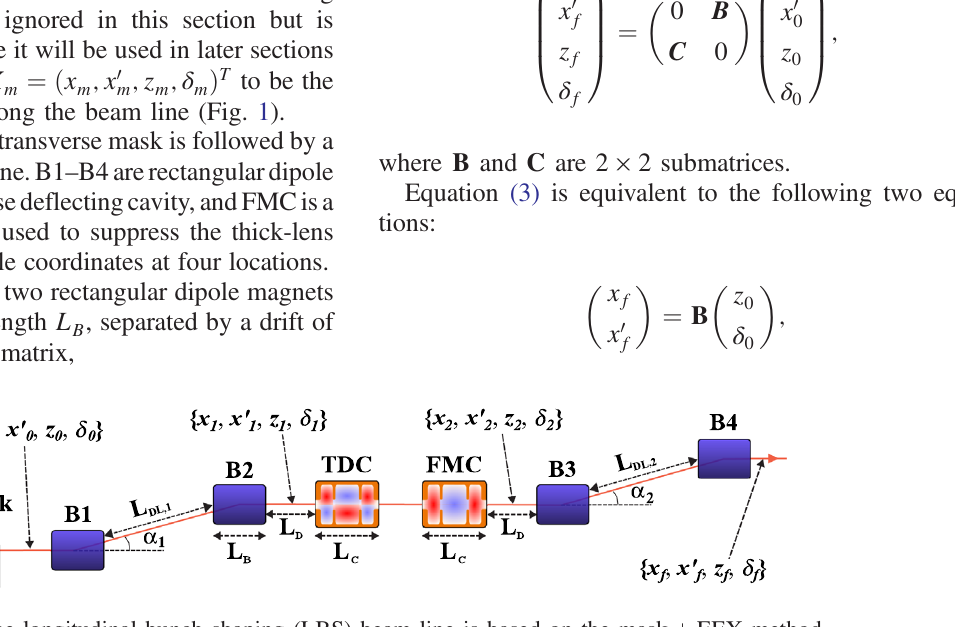
FIG. 1. The longitudinal bunch shaping (LBS) beam line is based on the mask þ EEX